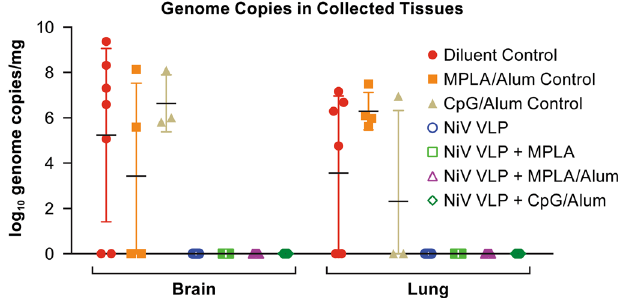
Fig. 3 PCR data from the three-dose vaccine trial. Data indicate the log 10 genome copies in the brain and lung collected at necropsy. Each marker represents an individual survived the infection and also had minimal signs of disease. Viral RNA was not detected in tissues of any of the animals in the NiV- VLP-vaccinated groups. The presence of viral RNA in collected tissues in all but one of the control animals, and in none of the vaccinated animals, demonstrates that the control animals had a productive infection while the vaccinated animals did not.